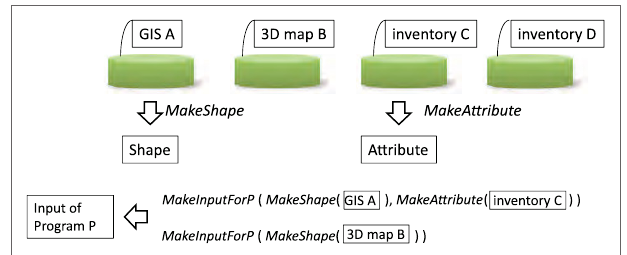
FigUre 5 | Two built-in functions of automated model construction system of IES.